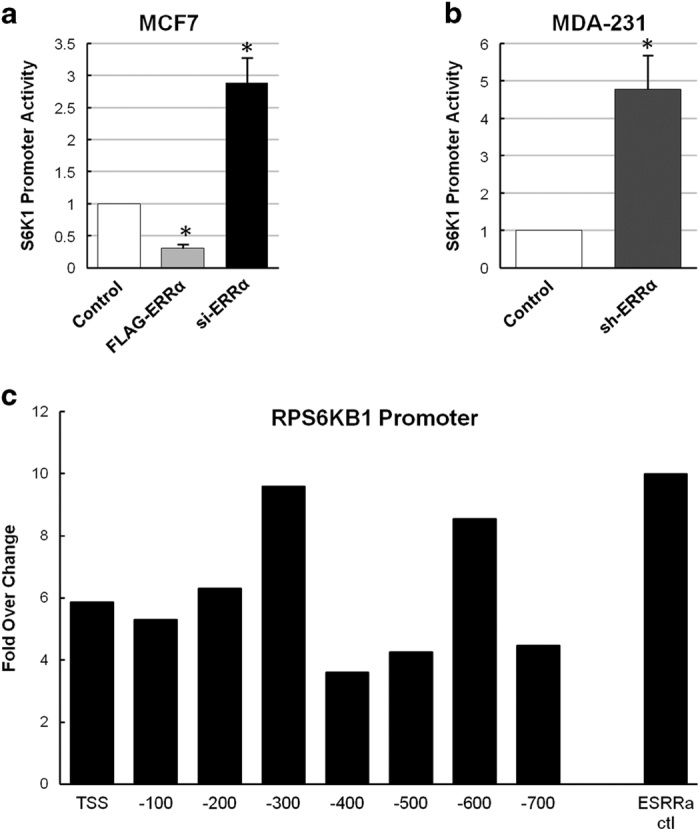
ERRα directly regulates S6K1 expression. (a) MCF7 cells were co-transfected with either FLAG-ERRα or siRNA targeting ERRα, the firefly luciferase S6K1 promoter reporter and Renilla luciferase control. Forty-eight hours post transfection, cells were lysed, and firefly luciferase expression was measured and normalized to control Renilla luciferase. (b) Stable MDA-MB-231 control cells or ERRα knockdown cells were co-transfected with FLAG-ERRα or siRNA targeting ERRα, the firefly luciferase S6K1 promoter reporter and Renilla luciferase control and analyzed as in a. (c) ChIP analysis of RPS6KB1 promoter occupancy in MCF7 cells was performed as described in ‘Materials and methods’ section. ERRα was immunoprecipitated using FLAG antibody and DNA enrichment was performed using RT-qPCR with primers spaced 100 bp relative to the transcription start site. Fold-over change was calculated with respect to no antibody control and normalized to histone H3 in each sample. ERRα promoter (ESRRA) was used as a positive control. All statistical analysis was performed using paired Student’s t-test. * represents P <0.05.